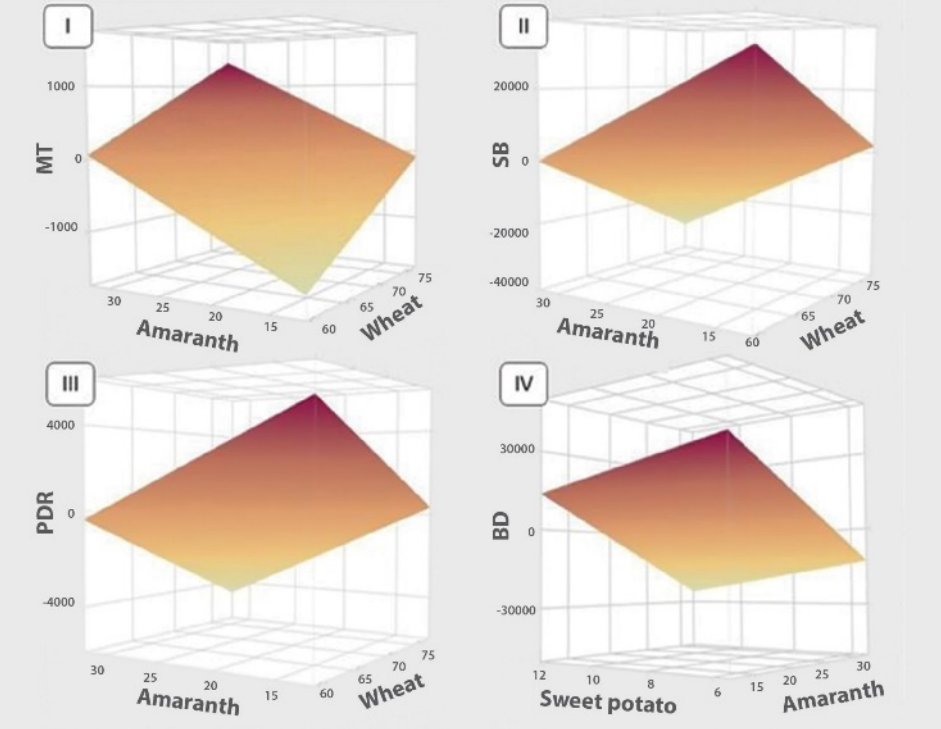
Figure 1. Determinant ingredients for the response variables: MT, mixing time; PDR, peak dough resistance; SB, set back; BD, breakdown.